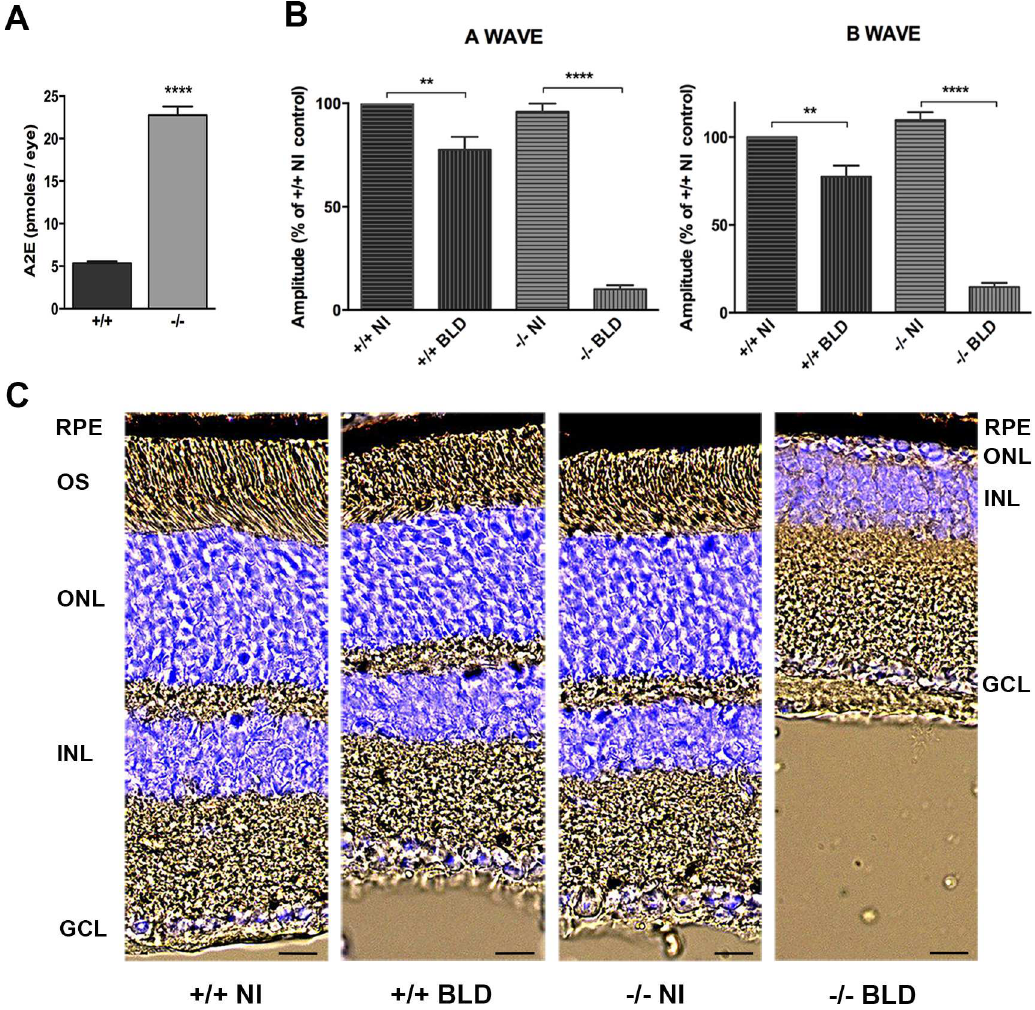
Fig 5. Effect of BLD on Abca4 -/- Rdh8 -/- and Abca4 +/+ Rdh8 +/+ mice carrying the Rpe65-Leu450 and the rd8 mutations. (A) A2E quantification in eyes from young (7–8 weeks) Abca4 +/+ Rdh8 +/+ (+/+) and Abca4 -/- Rdh8 -/- (-/-) mice. Bars represent mean ± s.e.m. of 3 eyes. **** p < 0.0001 (Student’s t Test). (B) BLD was inducedin +/+ and -/- during1 hour and ERGs were recorded7 days later. Non-illuminated +/+ mice were used as controls. A- and b-wave amplitudes are presented for the four groups and expressedas percentage of the non-illuminated +/+ control. Bars represent mean ± s.e.m. of two separateexperiments with n = 3–6. ** p < 0.01 **** p < 0.0001 (One-way ANOVA, Tukey’s post-test). (C) Representative cryosection pictures showingHoechst 33342 staining of the retinal cell nuclei one week after BLD. NI: non-illuminated. Scale bars = 20 μ m. OS: outer segment; ONL: outer nuclear layer; INL: inner nuclearlayer; GCL: ganglioncell